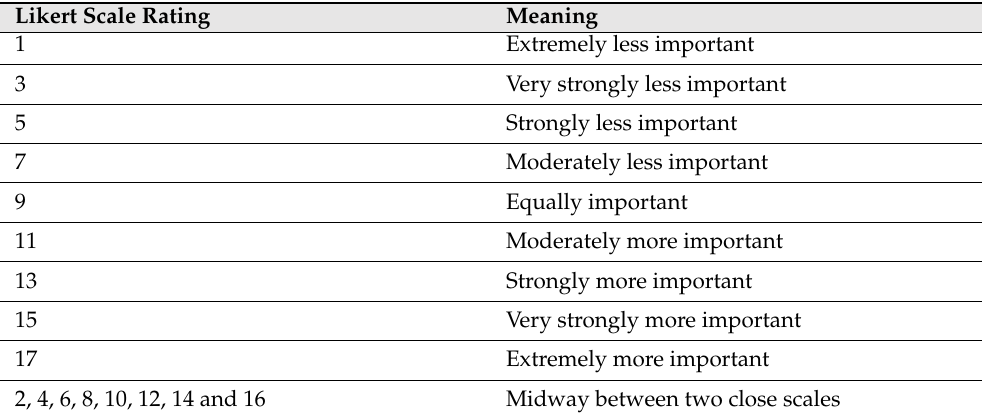
Table 2. Interpretation of Likert scales used in pairwise